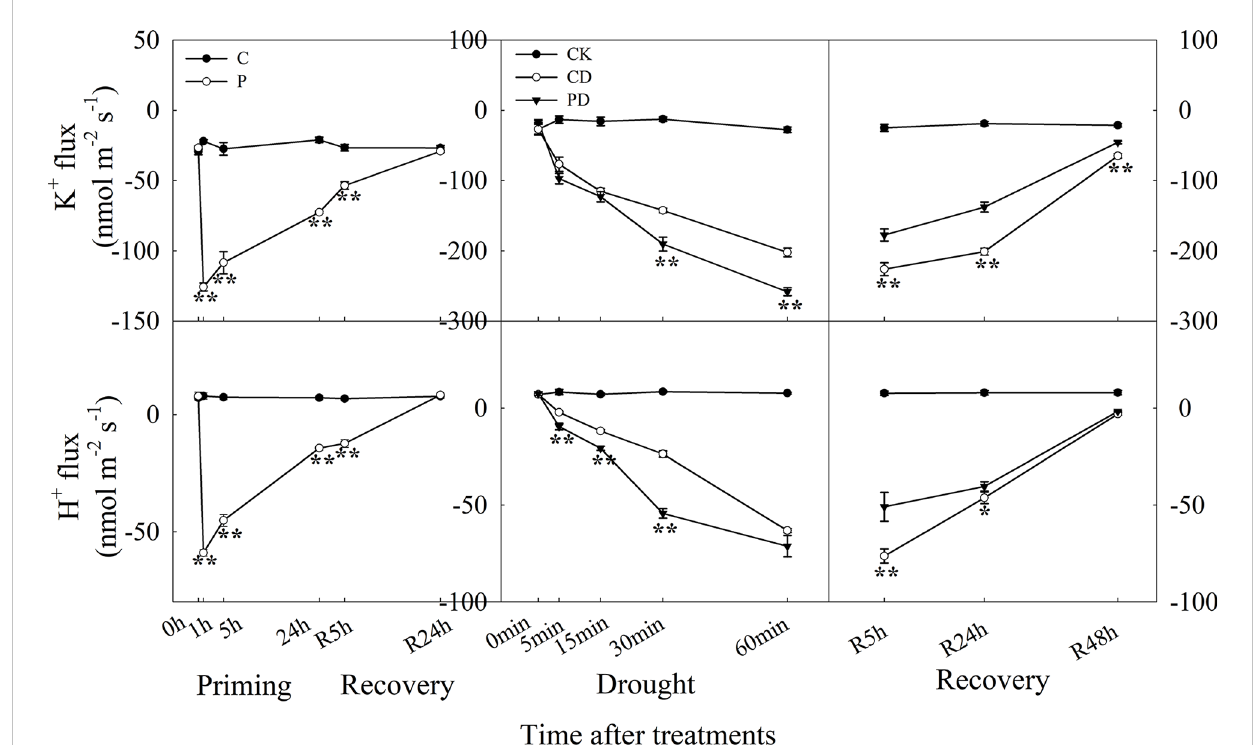
FIGURE 6 Dynamic responses of H + and K + fl uxes in leaf epidermis of wheat during “ drought priming-recovery-drought stress-recovery ” . C, no drought priming; P, priming; CK, no drought priming + no drought stress; PD, priming + drought stress; CD, no priming + drought stress. *p < 0.05; **p <